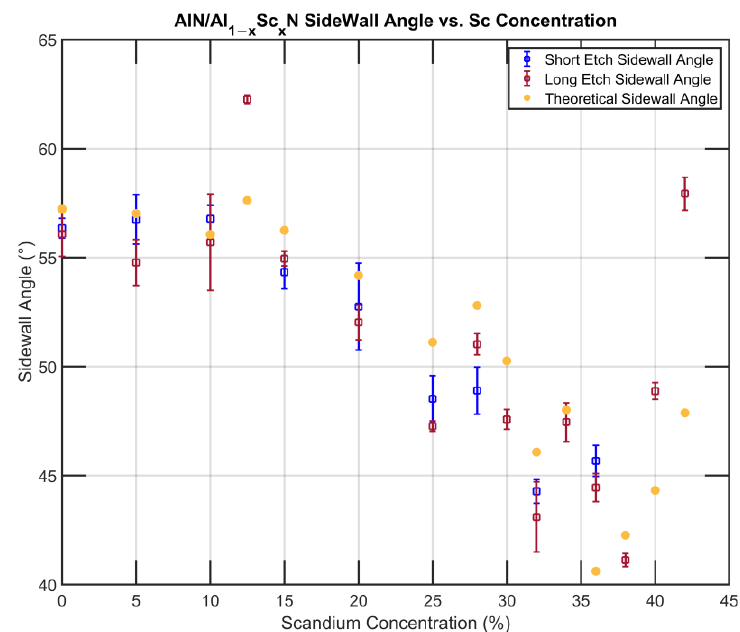
Figure 10. Comparison of experimental and theoretical sidewall angle vs. Sc concentration.